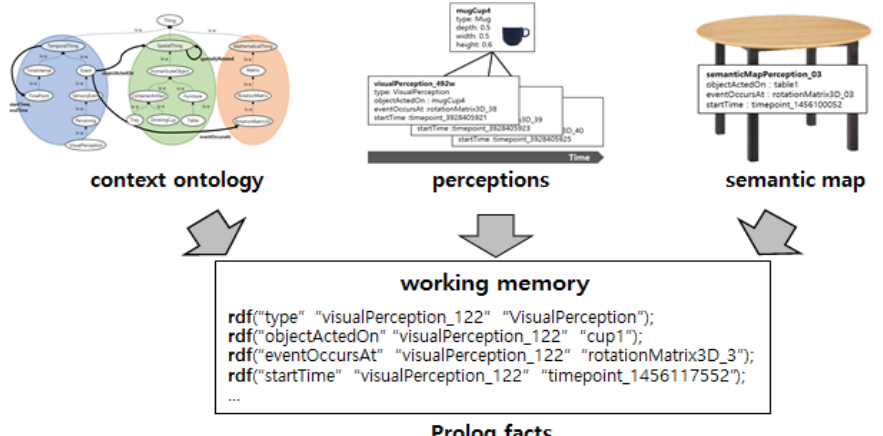
Figure 5. Translating context knowledge in the form of RDF/OWL to Prolog facts.